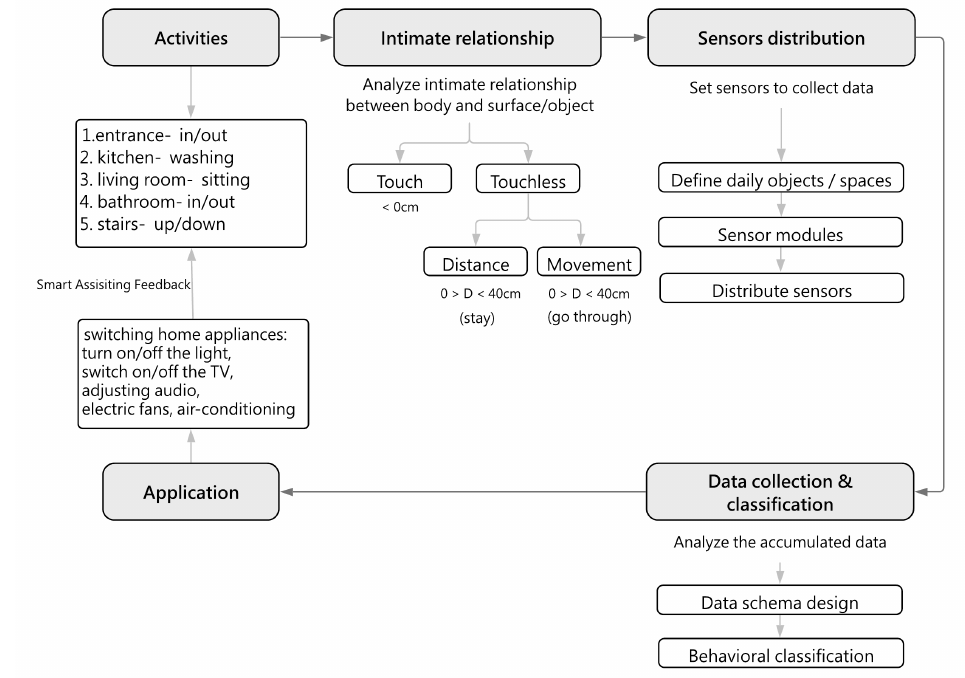
Figure 3. The design framework of Presence